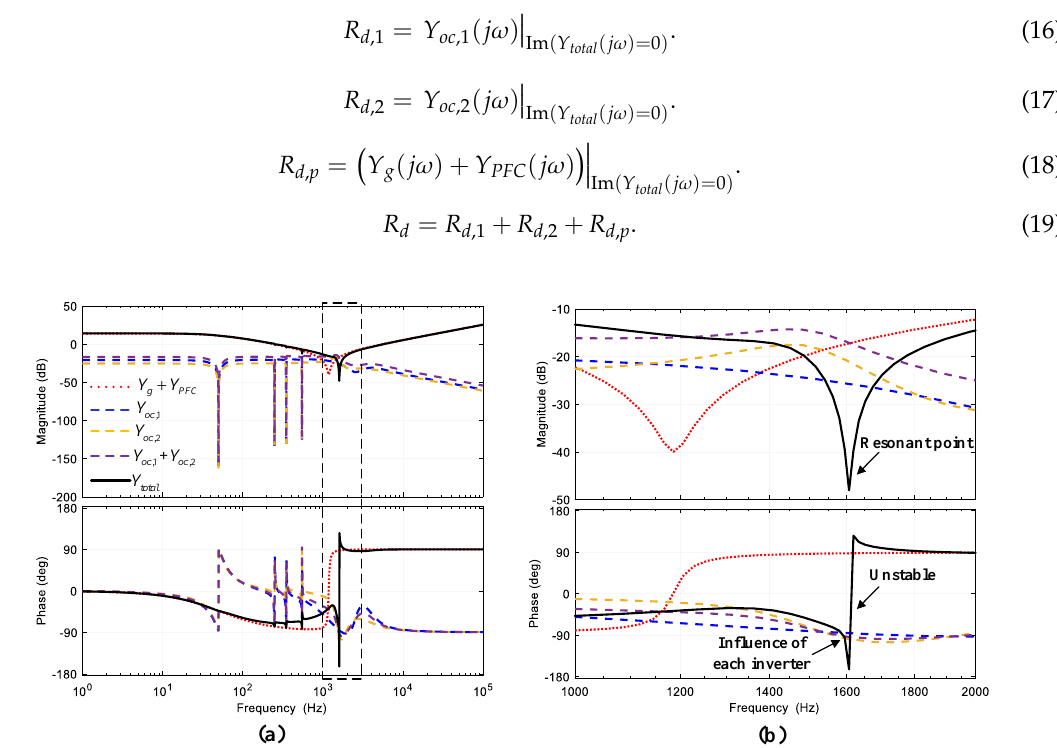
Table 3. Different real part of admittance.